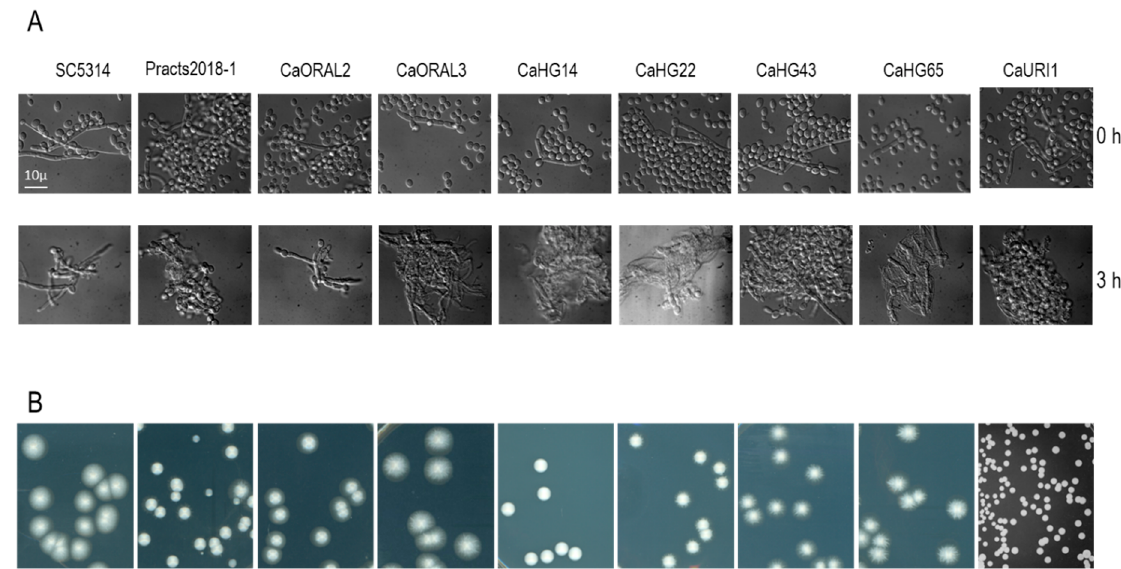
Figure 3. Ability to perform the yeast-to hypha transition in liquid and on solid media. ( A ) The strains indicated in the upper row were grown in YPD overnight at 37 °C (time 0) and refreshed in pre-warmed serum. Samples were taken 3 h later and photographed under the microscope. ( B ) In total 50 to 100 cells from cultures in the stationary phase were spread on Spider medium and incubated for 5 days at 37 °C.